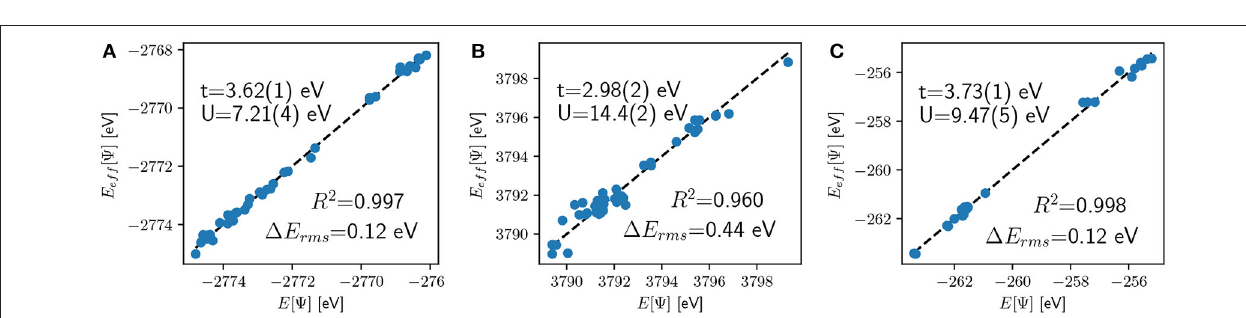
FIGURE 10 | Comparison of ab initio ( E [ ψ ]) and fitted energies ( E eff [ ψ ]) of the 3 graphene; (C) hydrogen